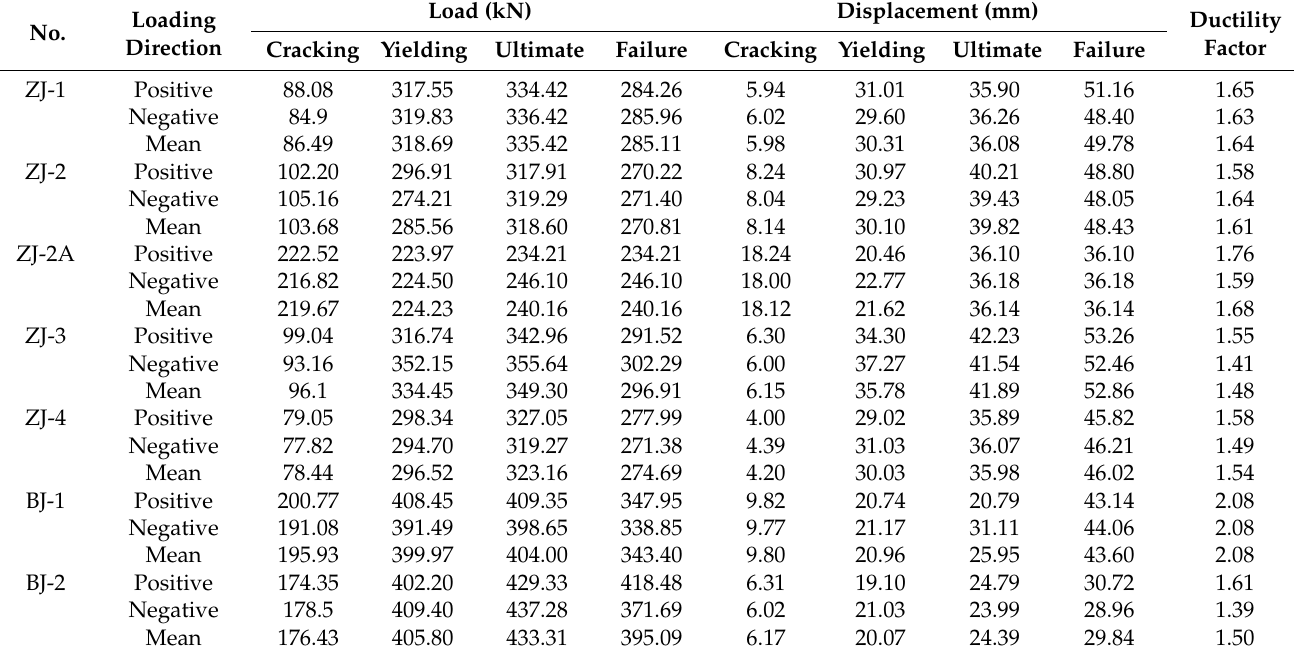
Table 5. Bearing capazity, displacement and ductility factors of